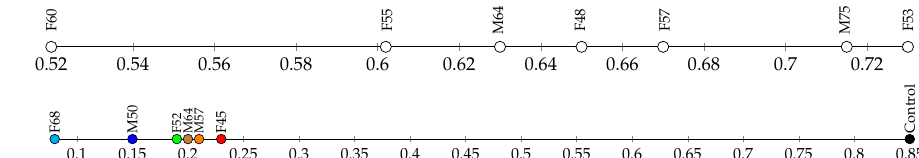
cm 2 ): ( top ) clinical BMD for different ·